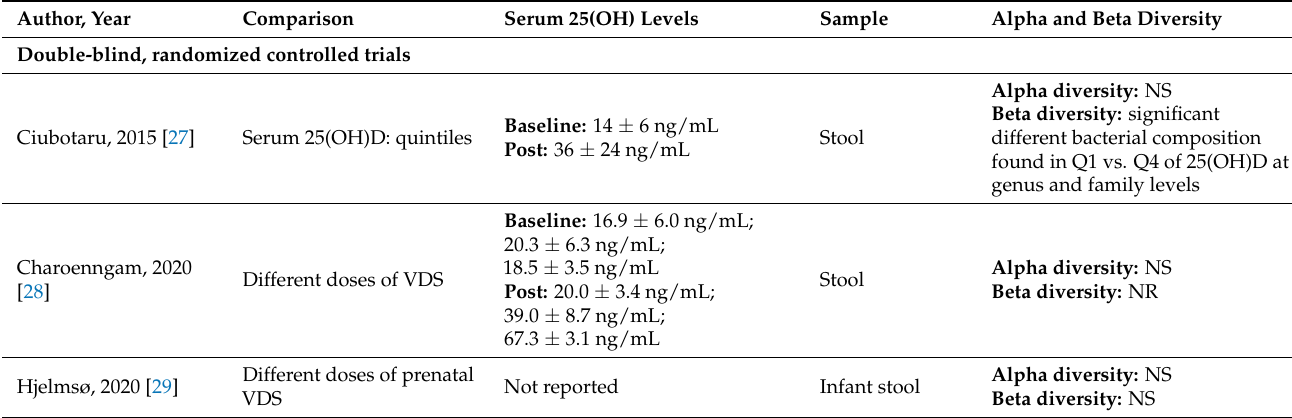
Table 2. Results of selected studies on alpha and beta diversity with vitamin D